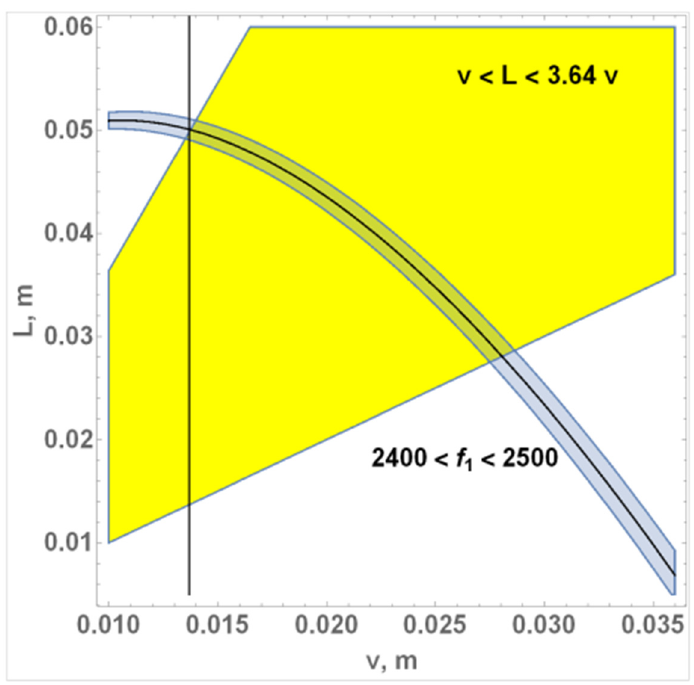
Figure 6. Wi-Fi frequency isolines and allowable areas for L and v.